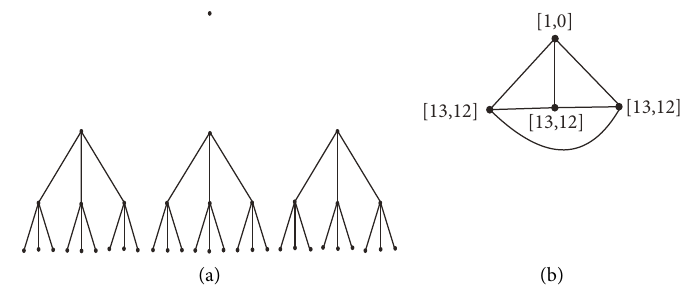
Figure 5: (a) THT ( 4 ) / F